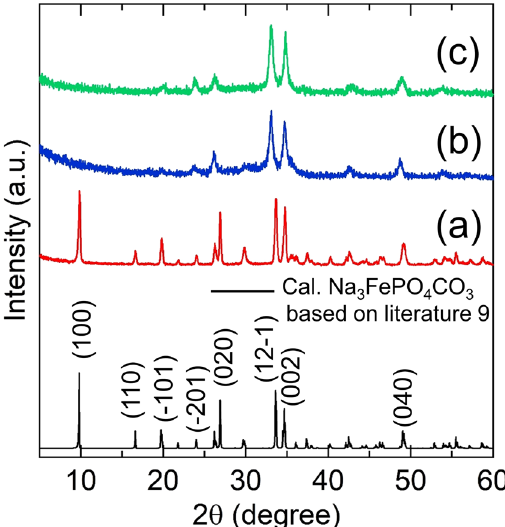
Figure 1. XRD patterns of Na 3 FePO 4 CO 3 synthesized by the hydrothermal method and denoted as HD_NFPC ( a ); Na